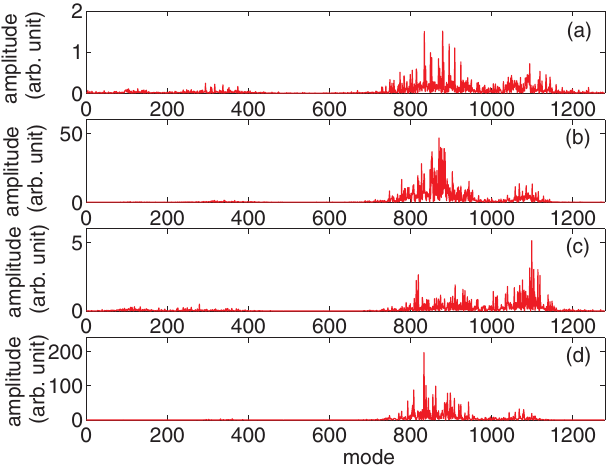
FIG. 17. (Color) Mode spectrum given by Fourier transforma- tion of the amplitude evolution for high secondary emission rate, (cid:1) 1 : 5 and a reflection of (cid:3) (cid:1) 0 : 5 . Plots (a) and (b) depict (cid:3) 2 ; max 0 the horizontal and vertical spectra, respectively, for electrons emitted at the illuminated point. Plots (c) and (d) depict the situation for electrons emitted uniformly.